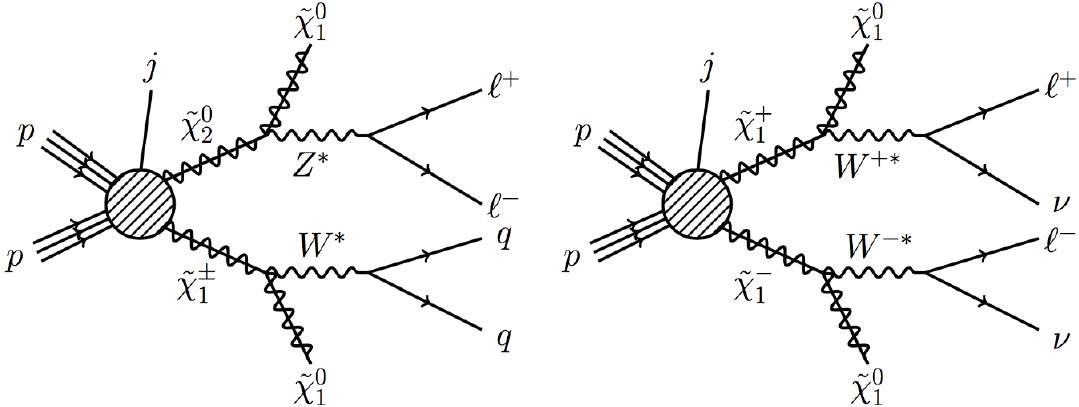
Figure 2. Direct electroweakino pair production in pp collision with leptonic (cid:12)nal states due to o(cid:11)-shell W (cid:3) and Z (cid:3) decays. The line labeled j denotes an ISR jet.